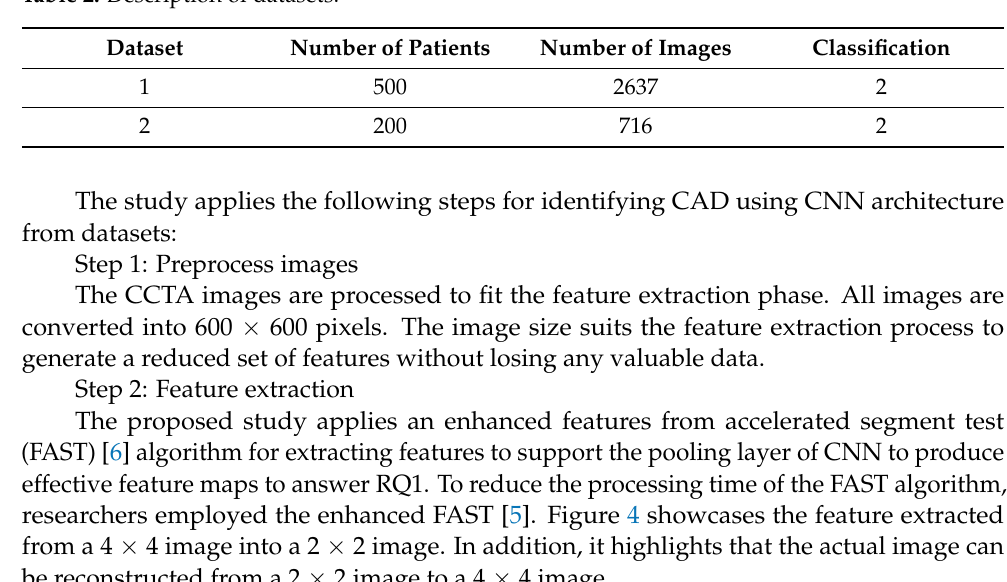
Figure 3. Superior vena cava images of individuals. Table 2. Description of datasets.